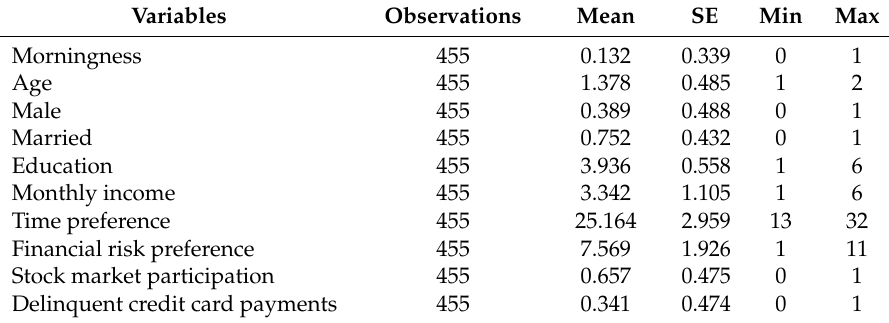
Table 1. Descriptive statistics of the study’s variables.